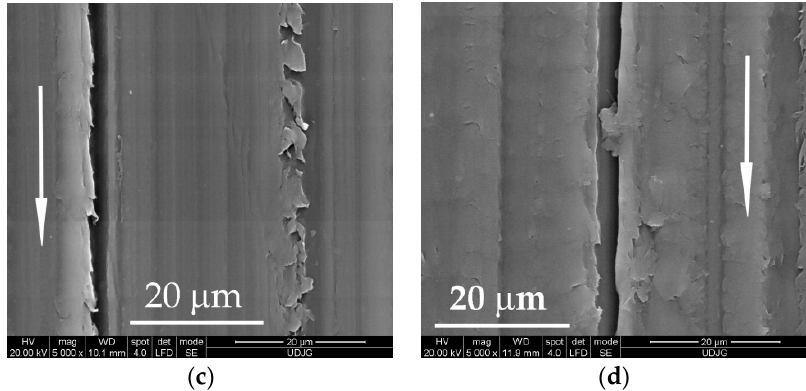
Figure 5. Details of the worn surface for the block made of PBT, L = 5000 m: ( a ) F = 1 N, v = 0.25 m/s; ( b ) F = 1 N, v = 0.75 m/s; ( c ) F = 5 N, v = 0.25 m/s; ( d ) F = 5 N, v = 0.75 m/s.